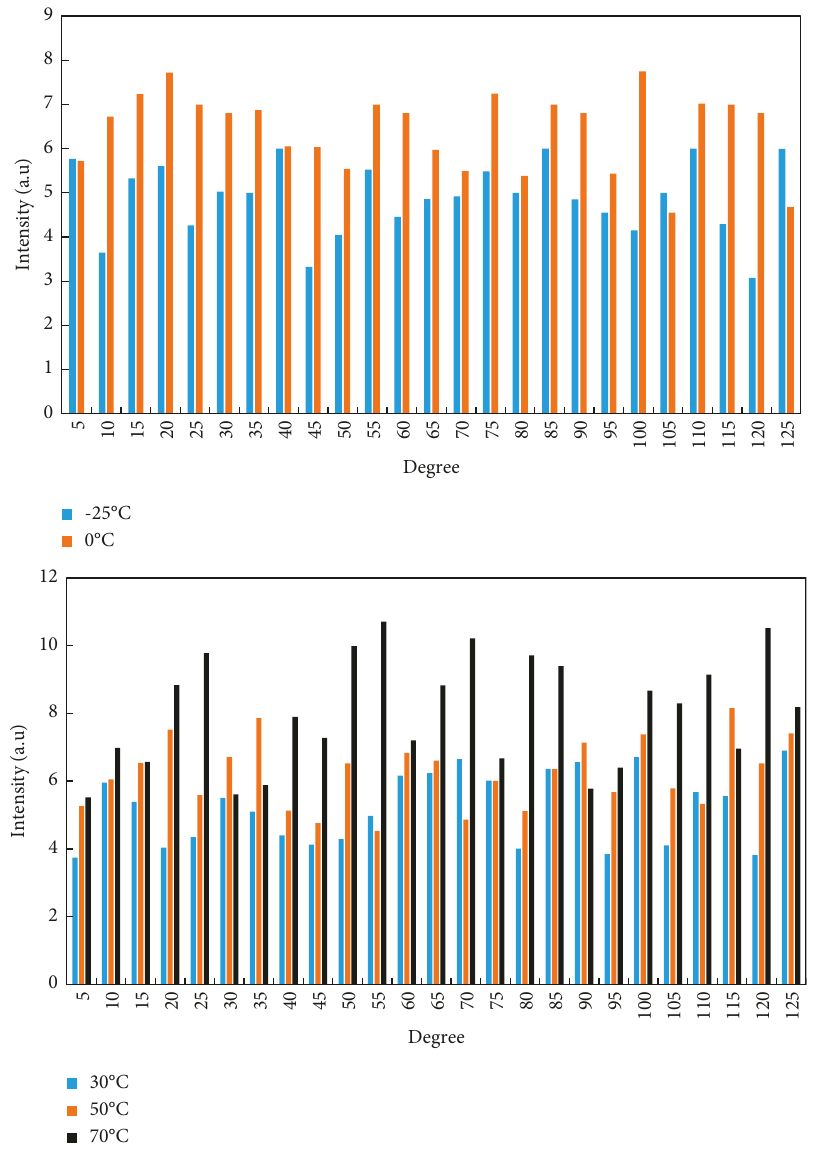
Figure 4: XRD test results at different